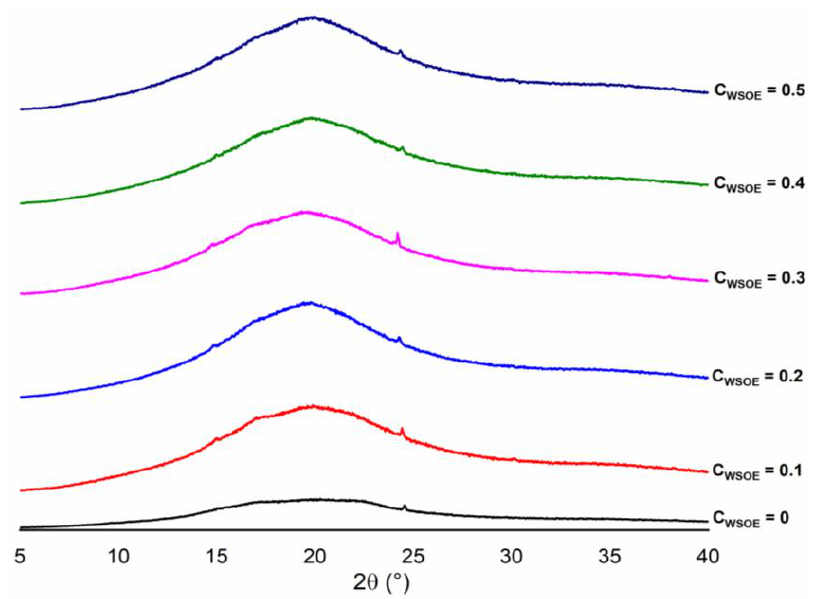
Figure 3. X-ray diffractogram of crosslinked starch-based films with different concentrations of watermelon seed oil emulsions (C WSOE , g/100 g of filmogenic solution).